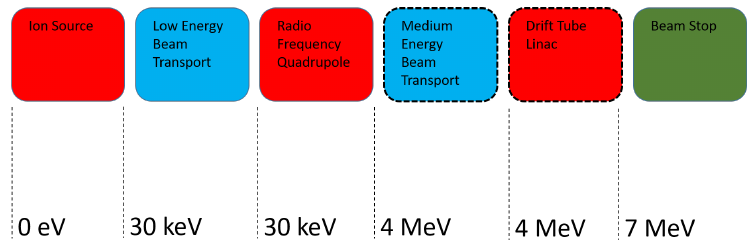
Figure 1. Simplified schematic of LINAC